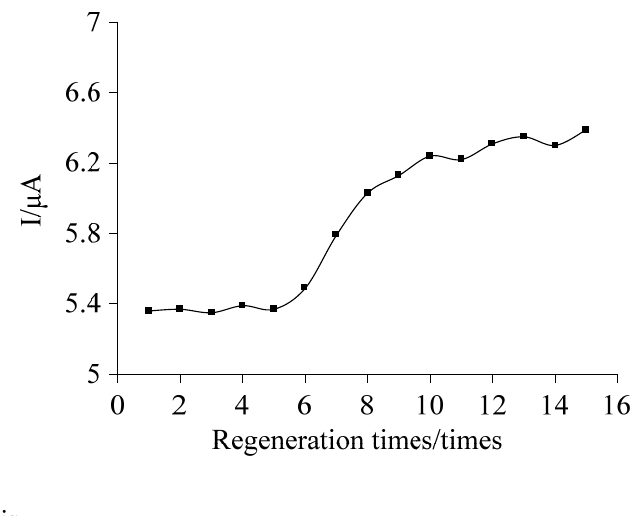
Figure 8. Regeneration performance of the immunosensor.